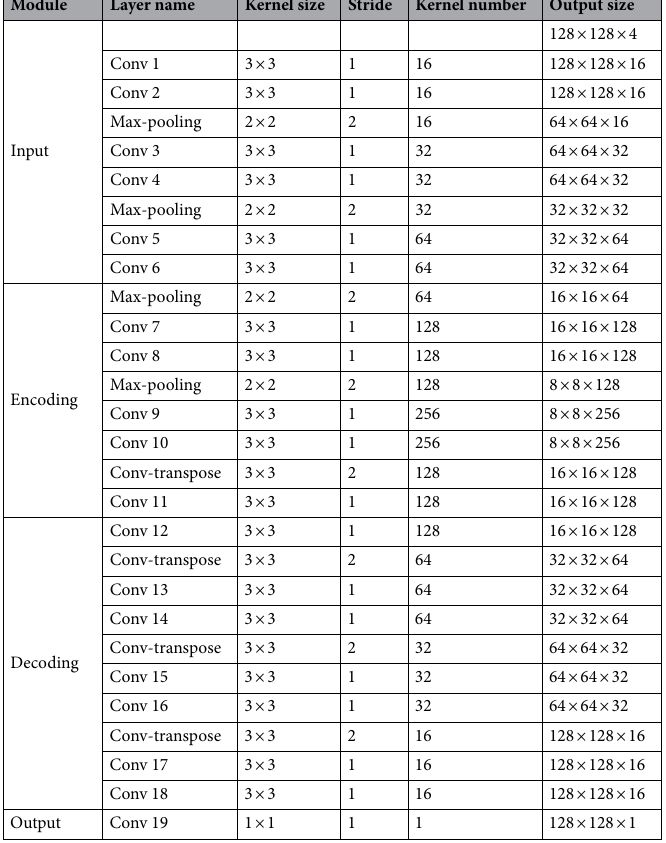
Table 2. Network structure of the U-Net architecture.